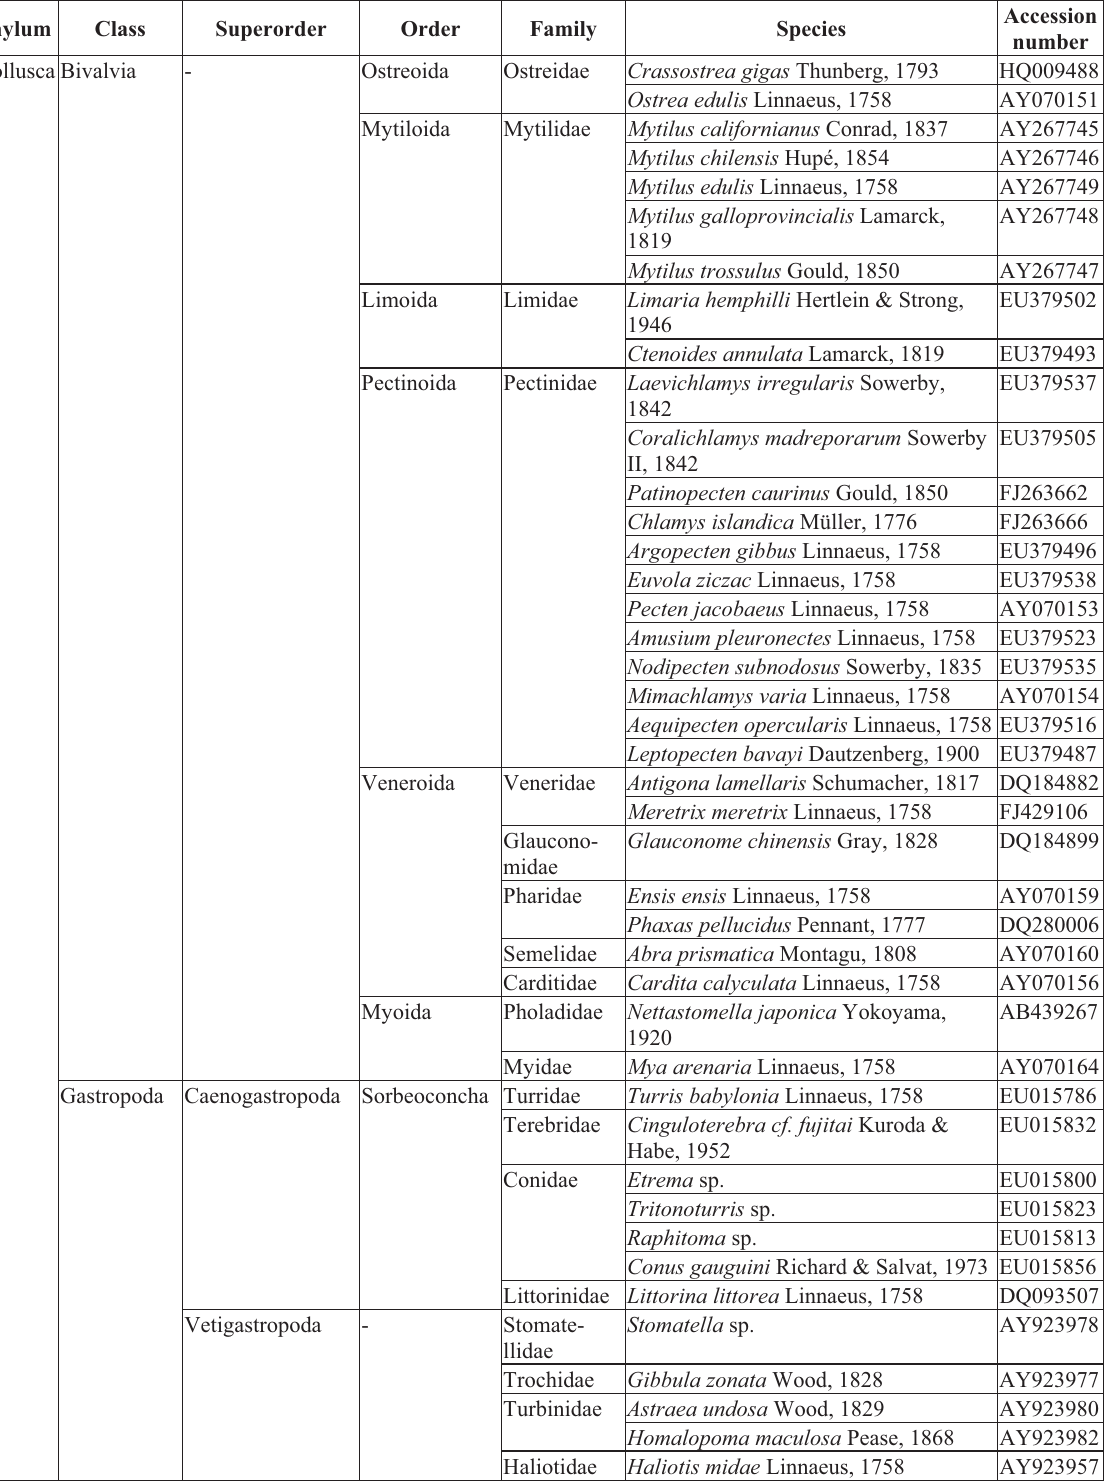
Table 1. List of histone H3 gene sequences in different molluscan species used for the phylogenetic analysis with GenBank accession